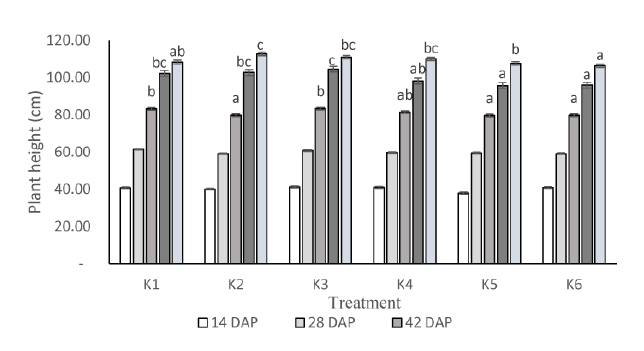
Figure 1 Average heights of rice plants at 14, 28, 42, 56, and 95 days after planting. Bars (means (cid:6) standard deviation; n = 3) with different letters are significantly different at LSD 0.05.